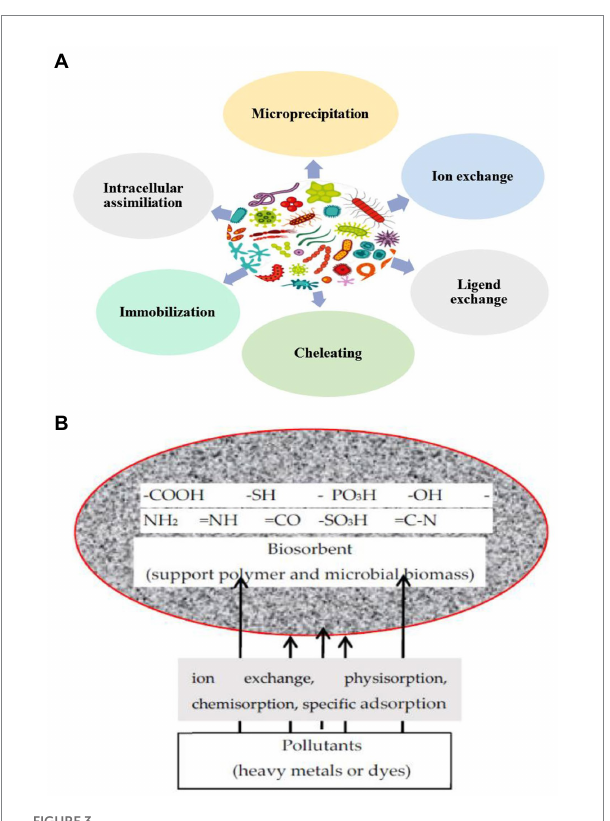
FIGURE 3 (A) Different ways to remediate environmental pollutants